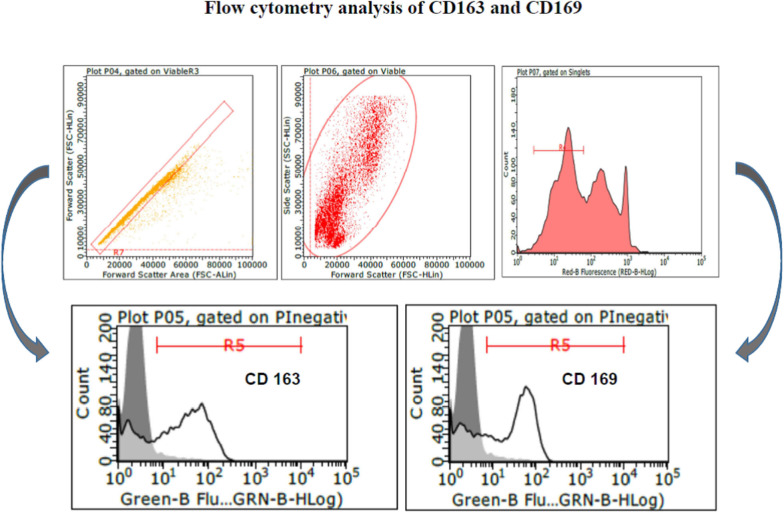
Swine PAM were stained with monoclonal antibodies 2A10/11 to porcine CD163 and 3B11/11 to porcine CD169, respectively, or FCB (control). Next, cells were reacted with Alexa Fluor® 488 F(ab′)2 fragment of goat antimouse IgG, IgM (H + L). After the final washing, cells were stained with PI and gated by a combination of forward and side scatter (FSC vs. SSC). Next, doublet and multiplet cells were discriminated from single cells in a FSC height/FSC area cytogram. Single, PI-negative (viable) cells were gated to histograms depicting the expression of CD163 and CD169, respectively. Dark area in the histograms: control reaction.